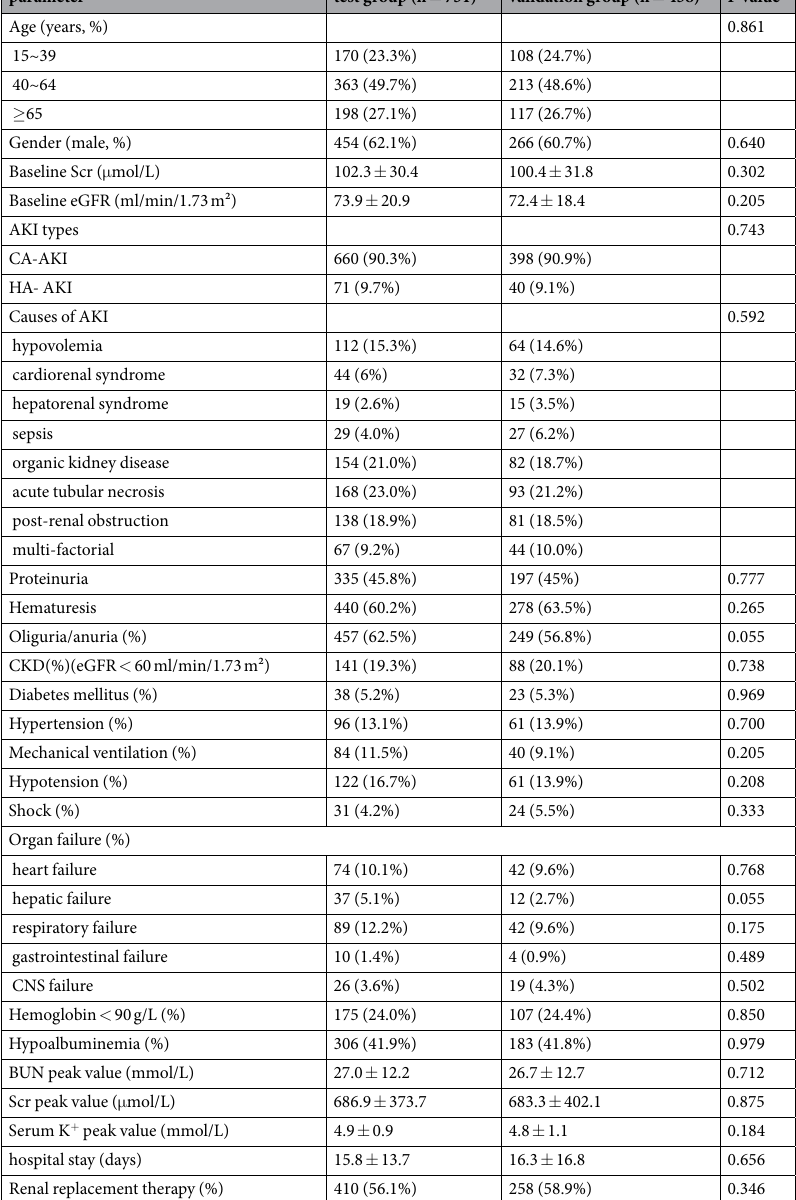
Table 1. Comparison of basic data between the test group and validation group. Abbreviation: Scr: serum creatinine; eGFR: estimated glomerular filtration rate; CA-AKI: Community-acquired AKI; HA-AKI: Hospital- acquired AKI; CKD: chronic kidney disease; BUN: Blood urea nitrogen; CNS: central nervous